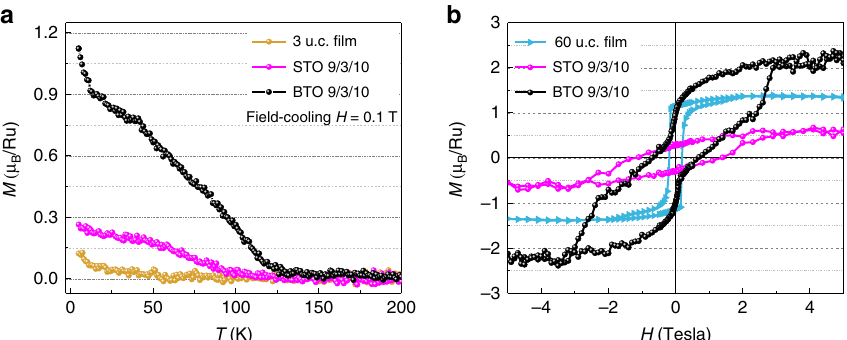
Fig. 3 Unusual magnetism in BTO 9/3/10. a Temperature dependence of magnetization for BTO 9/3/10, STO 9/3/10 and a bare 3 u.c. SRO fi lm under fi eld-cooling (FC) measured by applying a magnetic fi eld H = 0.1 T normal to the fi lm plane. A pronounced magnetic transition at 125 K is shown in BTO 9/ 3/10. In contrast, STO 9/3/10 and bare 3 u.c. SRO show small magnetic moments. b Magnetic hysteresis loop measured at 5 K for the BTO 9/3/10 with saturated moment of ~2.3 μ B /Ru. The STO 9/3/10 shows weak ferromagnetism with saturated moment of ~0.6 μ B /Ru and the 60 u.c. SRO fi lm shows normal ferromagnetism with saturated moment of ~1.4 μ B /Ru. Note that BTO and STO are diamagnetic in the entire temperature range investigated